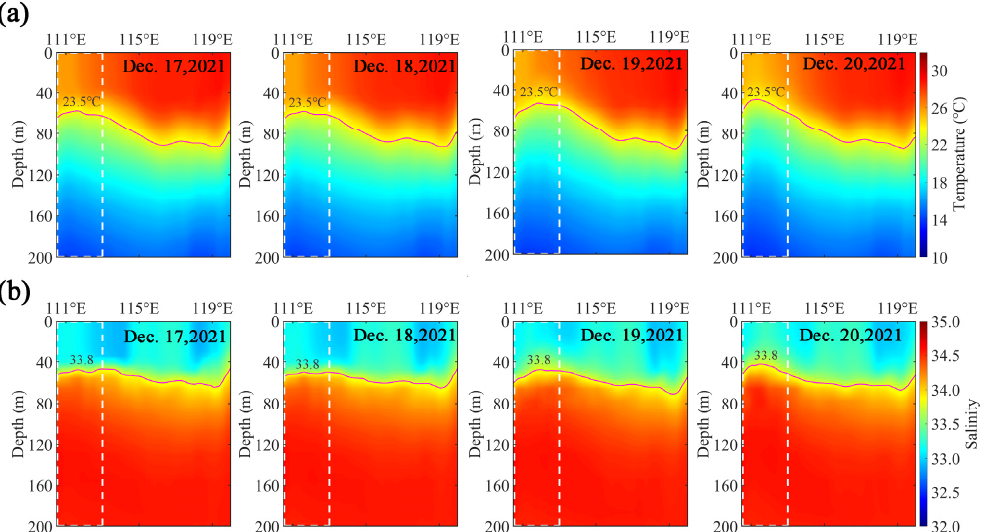
Figure 10. Vertical profile of ( a ) temperature and ( b ) salinity averaged along the latitude before and after the passage of STY “Rai”. Before the passing of STY (17–18 December 2021), after the passing of STY (19–20 December 2021). Vertical profile of the white dotted line box was the black box C in Figure 1. The red lines represent ( a ) 23.5 °C isotherm and ( b ) 33.8 isohaline.